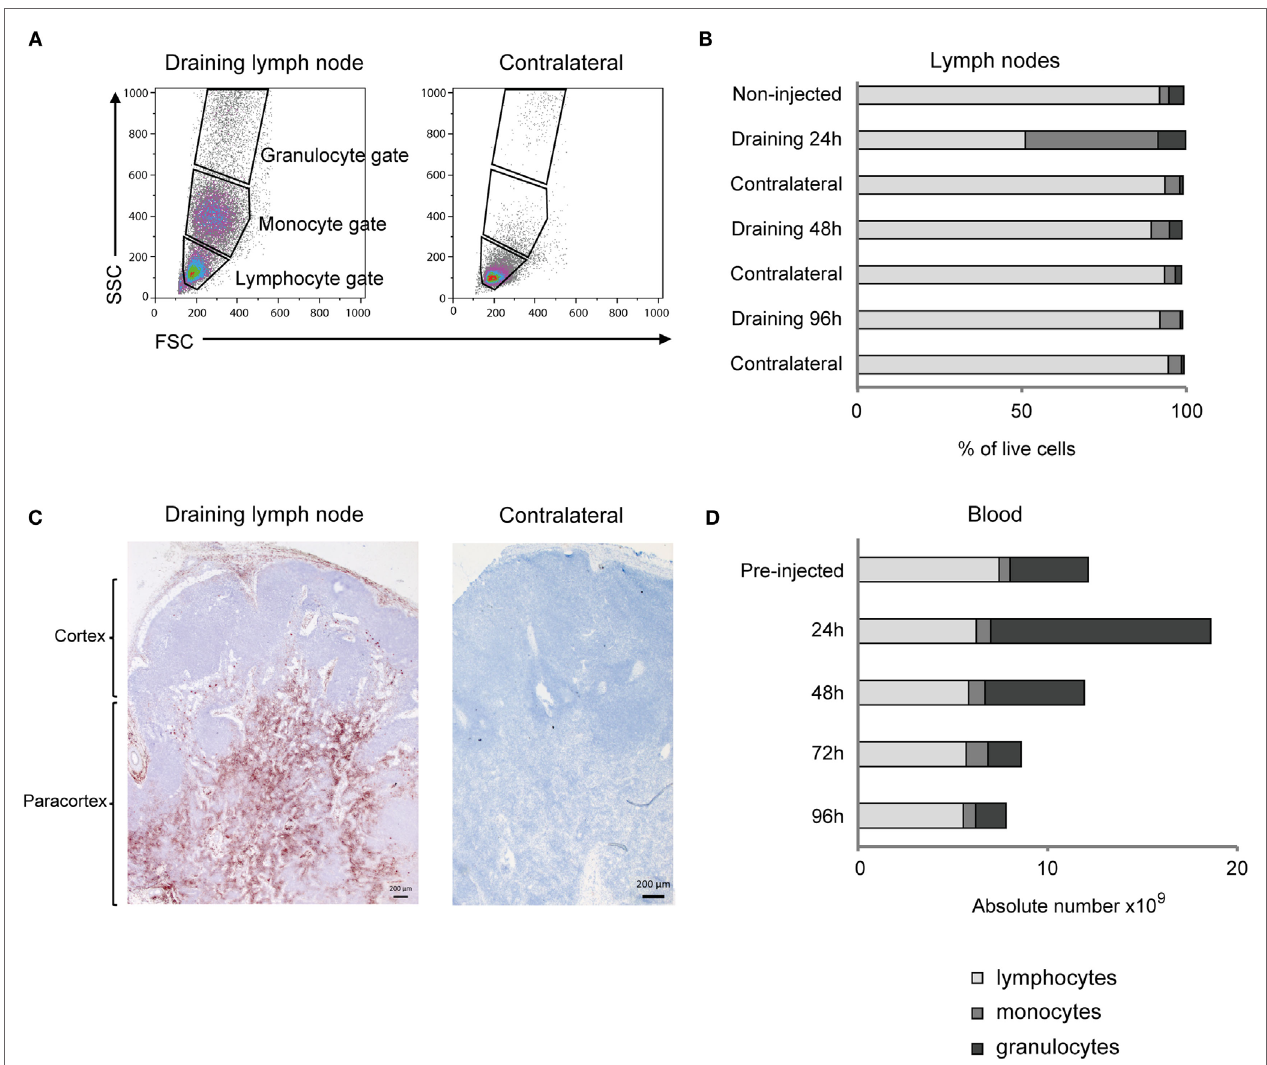
FigUre 2 | cellular recruitment to lymph nodes (ln) and peripheral blood . (a) LN cells were prepared for FCM analysis and gated on forward/side scatter (FSC/SSC) characteristics. Plots from one representative animal are presented. Panels illustrate the gating of lymphocytes, monocytes, and granulocytes as indicated and in the draining LN (left) and the contralateral LN (right), at 24 h post-injection. (B) Percentages of major immune cell populations in LNs, based on the gating strategy in A. Horizontal stacked bars show mean percentages of lymphocytes (gray), monocytes (dark gray), and granulocytes (black) of the total live cell population in non-injected animals ( n = 6) and at different time points after adjuvant injection ( n = 2–3). (c) IHC labeling of draining and contralateral LNs at 24 h post-injection with antibody against CD14. Different regions of the LN are indicated. (D) Cellular differential counts in peripheral blood. Horizontal stacked bars show mean absolute numbers ( × 10 9 ) of lymphocytes (gray), monocytes (dark gray), and granulocytes (black) at pre-injection and at different time points after adjuvant